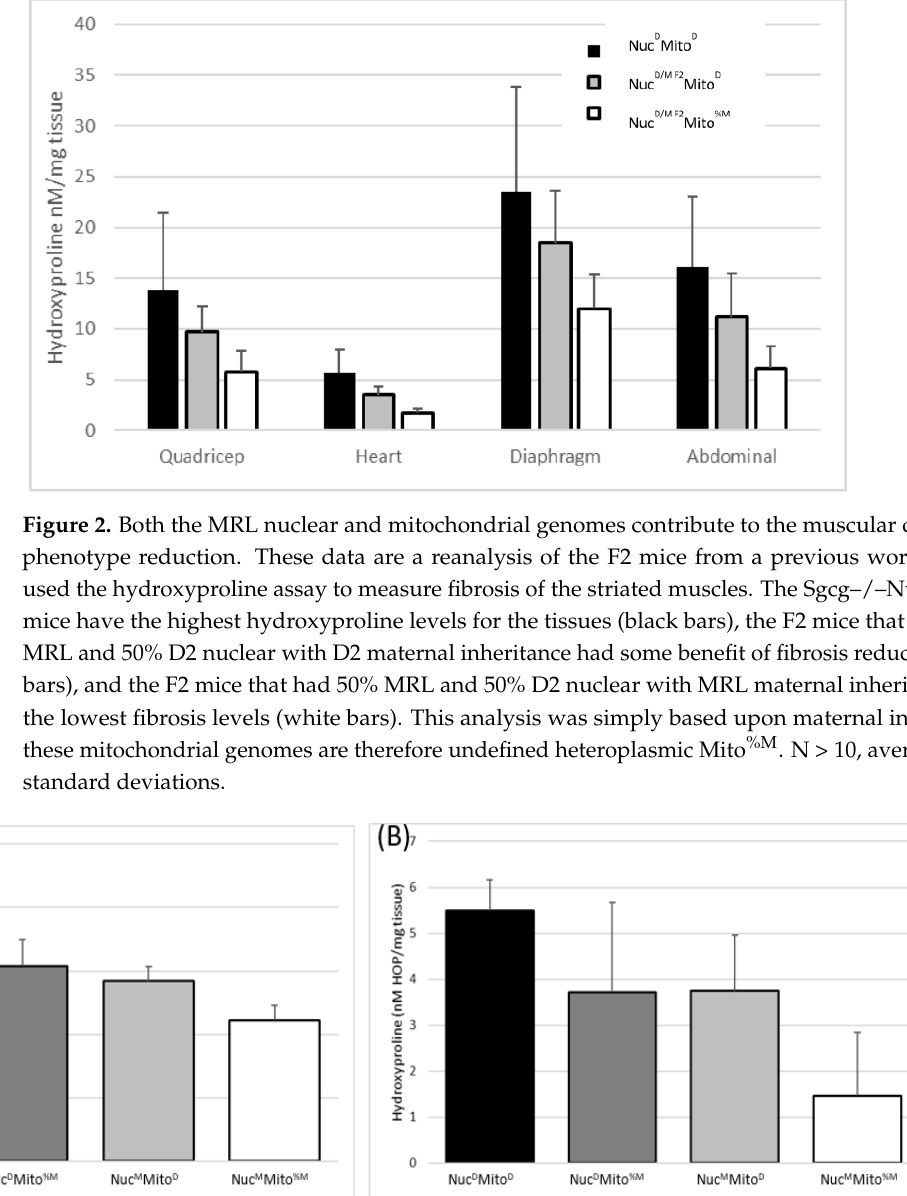
Figure 2. Both the MRL nuclear and mitochondrial genomes contribute to the muscular dystrophy phenotype reduction. These data are a reanalysis of the F2 mice from a previous work [4]. We used the hydroxyproline assay to measure fibrosis of the striated muscles. The Sgcg – / – Nuc D Mito D mice have the highest hydroxyproline levels for the tissues (black bars), the F2 mice that were 50% MRL and 50% D2 nuclear with D2 maternal inheritance had some benefit of fibrosis reduction (grey bars), and the F2 mice that had 50% MRL and 50% D2 nuclear with MRL maternal inheritance had the lowest fibrosis levels (white bars). This analysis was simply based upon maternal inheritance; these mitochondrial genomes are therefore undefined heteroplasmic Mito %M . N > 10, averages with stand- ard deviations.